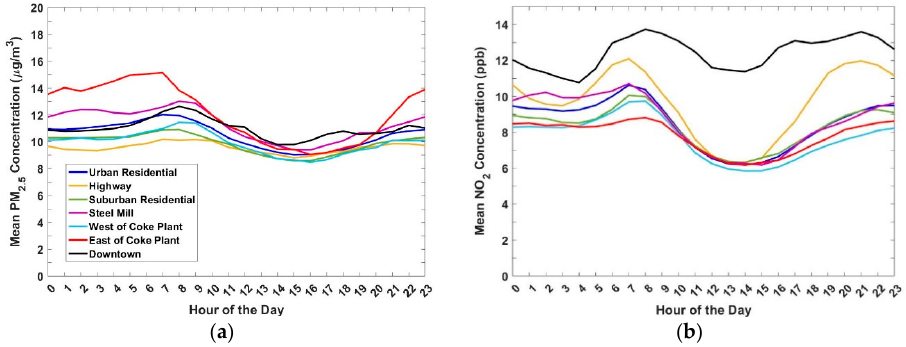
Figure 5. ( a ) Hourly averaged diurnal patterns of PM 2.5 within each site group. Downtown site 2, which is impacted by emissions from a nearby restaurant, is not included. ( b ) Mean diurnal patterns of NO 2 for each of the site groups. All sites were used because the restaurant near site 2 is not a major NO 2 source.